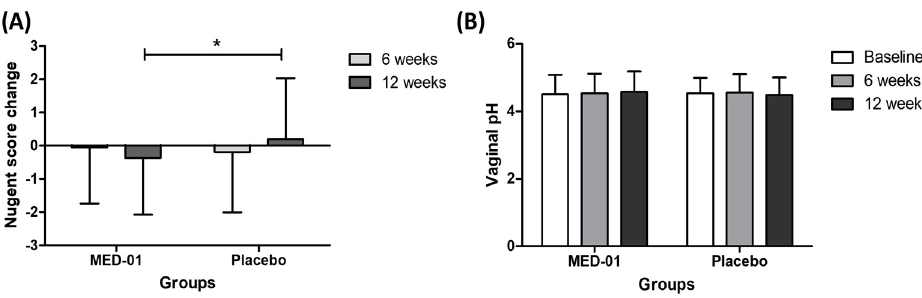
Figure 2. Effect of MED-01 on ( A ) the Nugent score and ( B ) vaginal pH from baseline to 12 weeks after randomization; Values are presented as mean ± SD; * p < 0.05 derived from an analysis of covariance (ANCOVA) between groups, MED-01 vs. placebo. Table 3. N umber of participants with bacterial vaginosis (BV) status after consuming of food sup- plements as determined by the Nugent scores in the MED-01 and placebo groups.